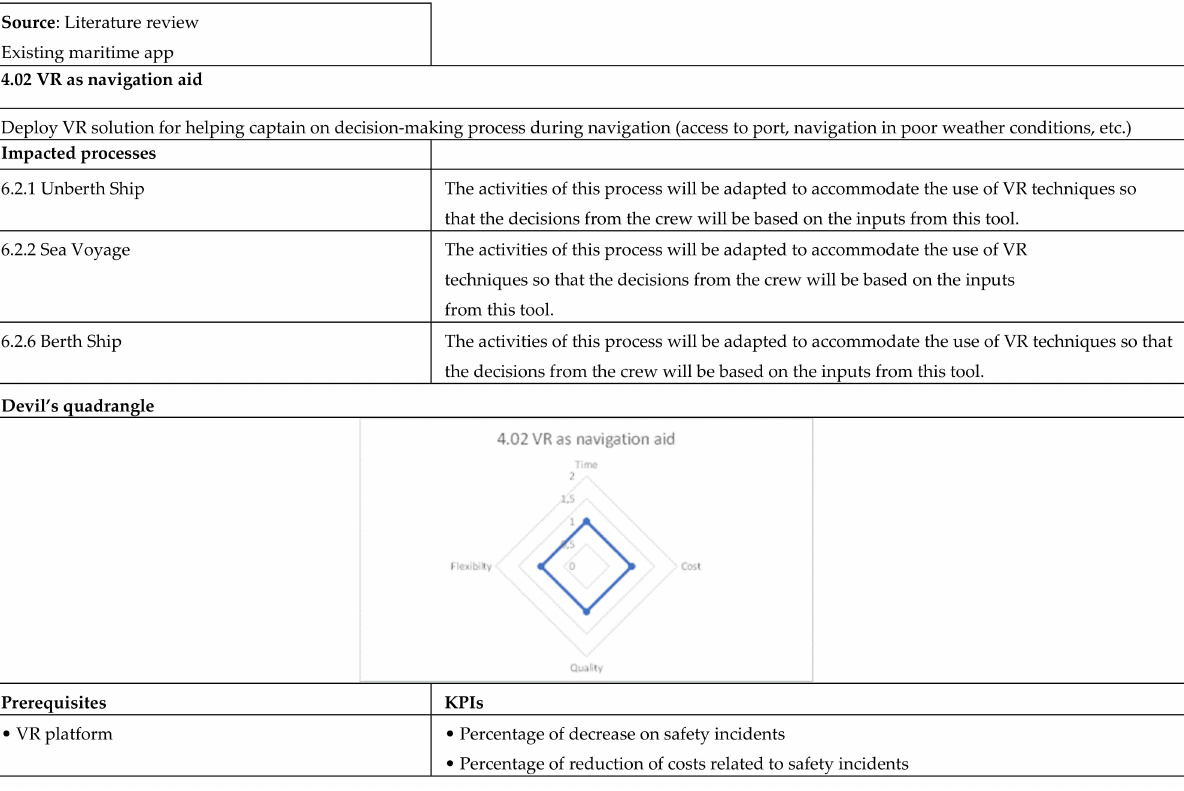
Figure A34. VR as navigation aid data sheet.